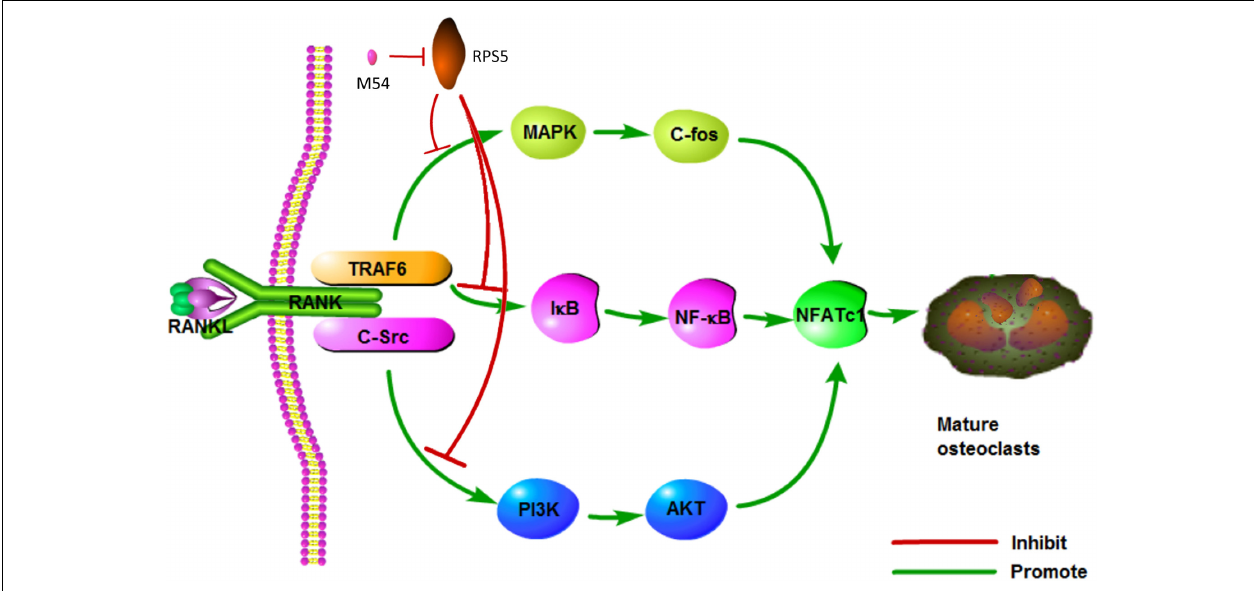
FIGURE 7 | A schematic diagram which describes the mechanism that M54 inhibits RANKL-induced osteoclastogenesis. RANKL-RANK signaling induces NFATc1 expression through NF- κ B, MAPKs, and PI3K/AKT pathways. M54 acts on the RPS5 and blocks NF- κ B, MAPKs, and PI3K/AKT pathways and, subsequently, suppresses NFATc1